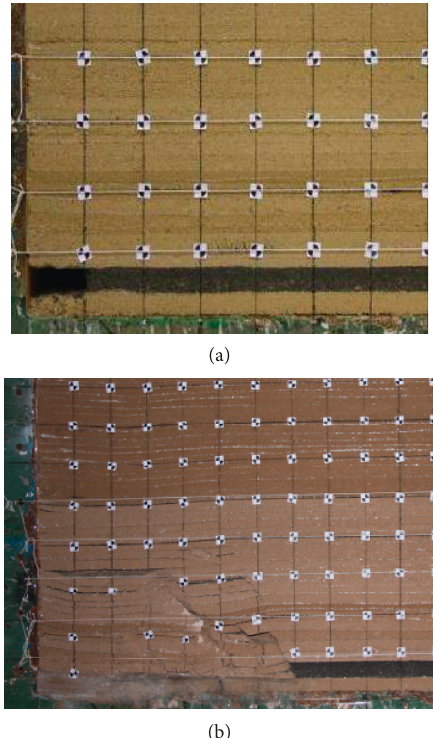
Figure 7: Mining process with caving method. (a) Left first ex- cavation; (b) completed excavation of the left side.